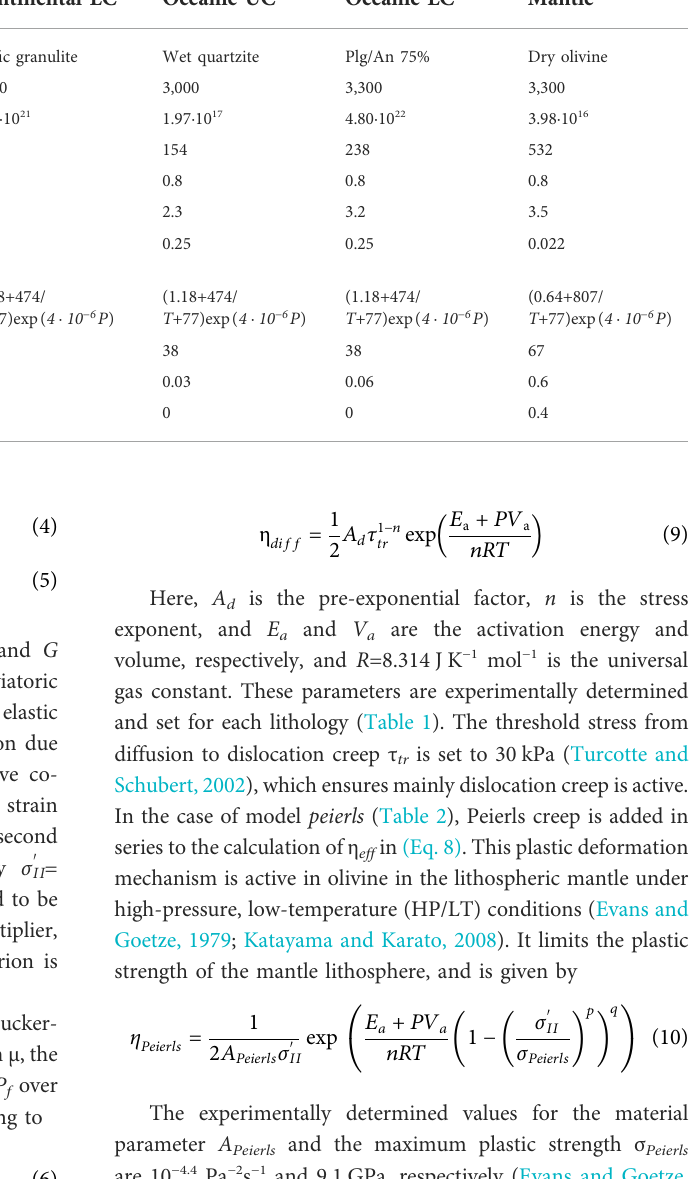
TABLE 1 Rheological parameters used for the reference model. All materials have an isobaric heat capacity C p of 1000 J/(kg K), thermal expansion α =3 · 10 – 5 K − 1 and isothermal compressibility β =10 – 5 MPa − 1 a Ranalli, (1995); b Turcotte and Schubert, (2002); c Rudnick and Fountain, (1995).